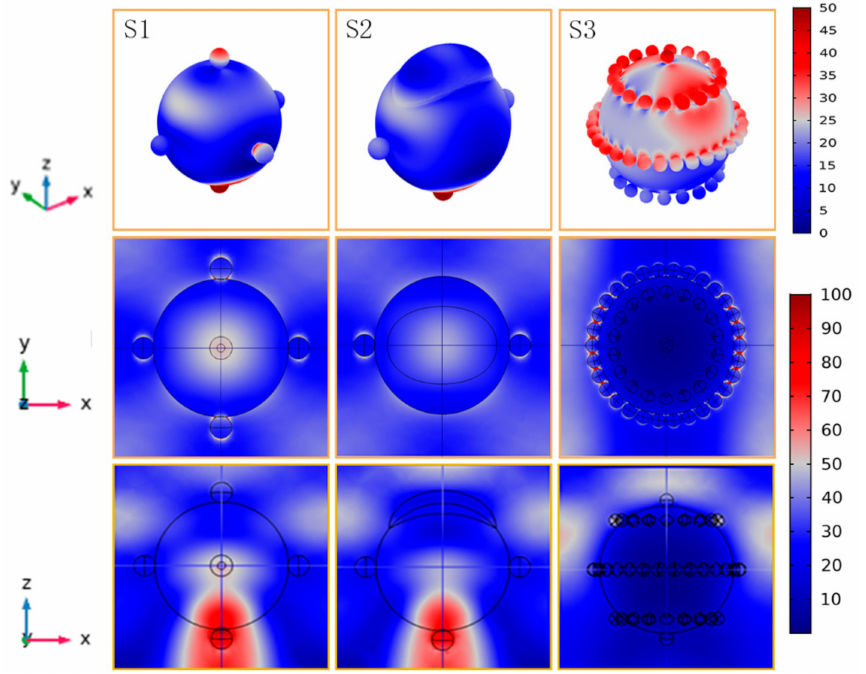
Figure 1. Three-dimensional electromagnetic enhancement distribution (stereoscopic view, top view and front view) of SiO 2 @Ag in S1, S2 and